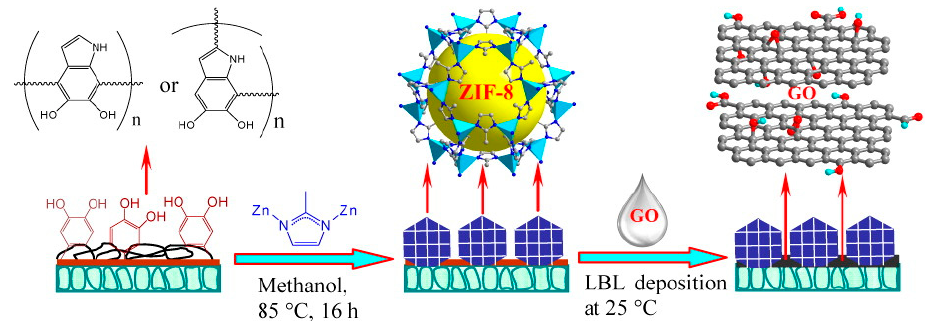
Figure 7. Scheme of the preparation of bicontinuous ZIF-8@GOmembranes through the layer-by-layer deposition of graphene oxide on the semicontinuous ZIF-8 layer, which was synthesized on a polydopamine-modified alumina disk (adapted with permission from ref. [86]).